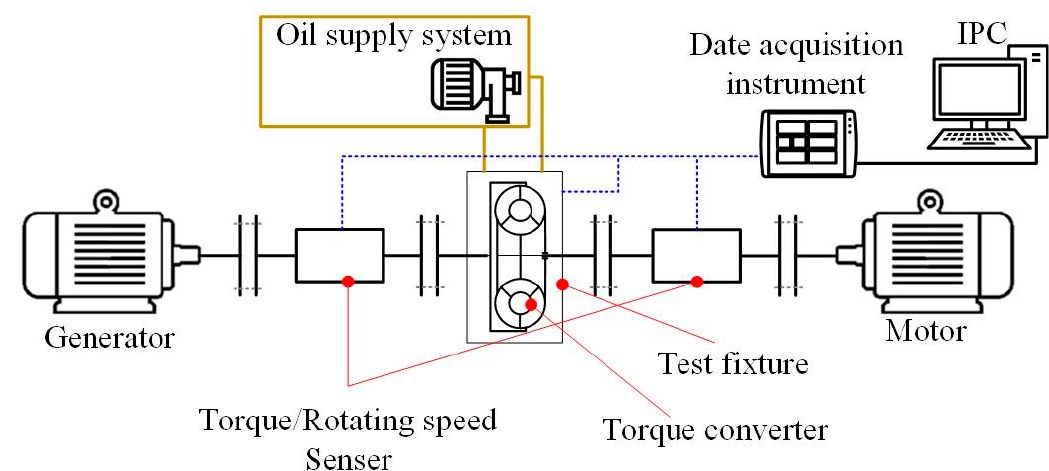
Figure 6. Test rig’s schematic layout.